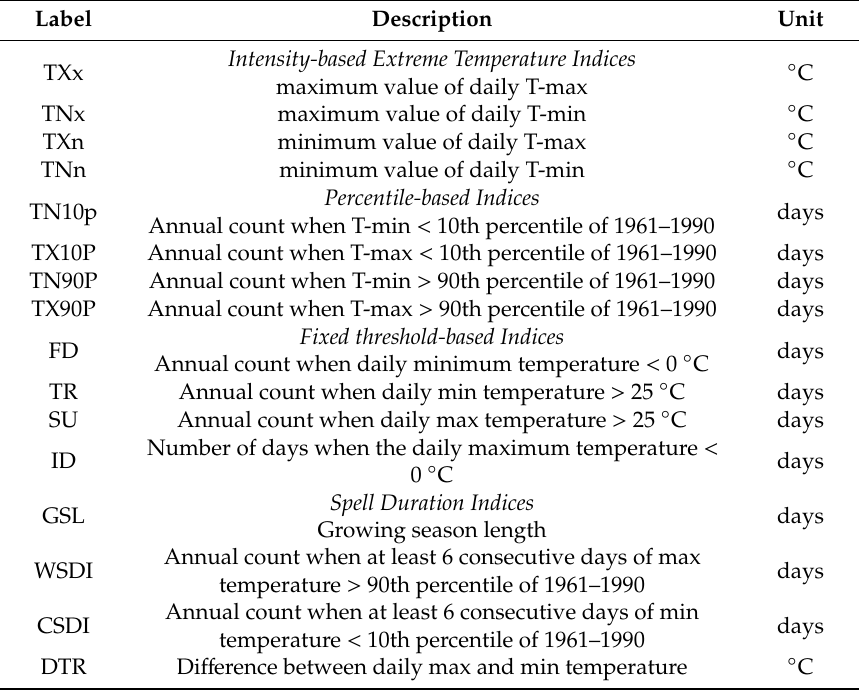
Table 2. Information on the climate extreme indices analyzed in this study. All indices were calculated